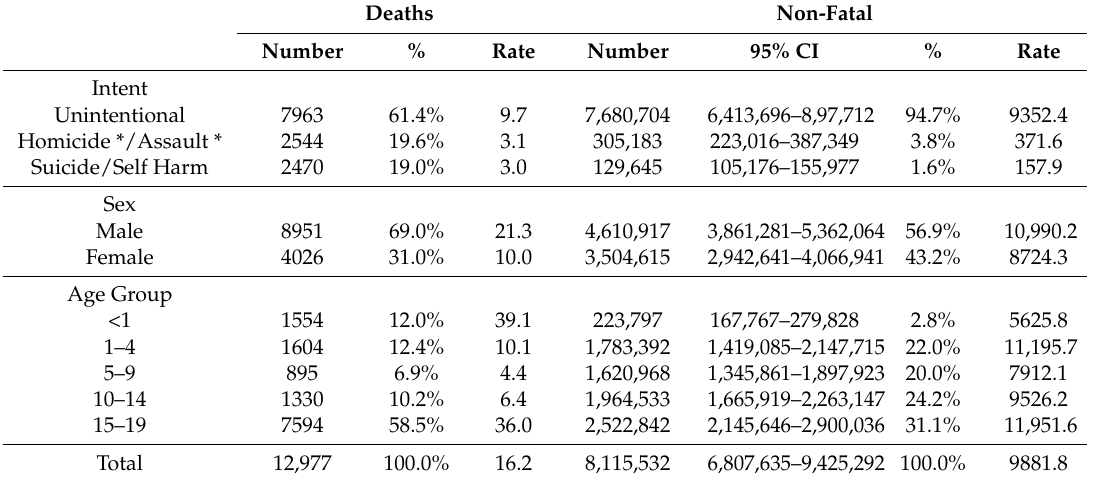
Table 1. Fatal and non-fatal injuries among youth aged 0–19 years by intent, sex, and age group, National Vital Statistics System and National Electronic Injury Surveillance System-All Injury Program, United States, 2015. Deaths